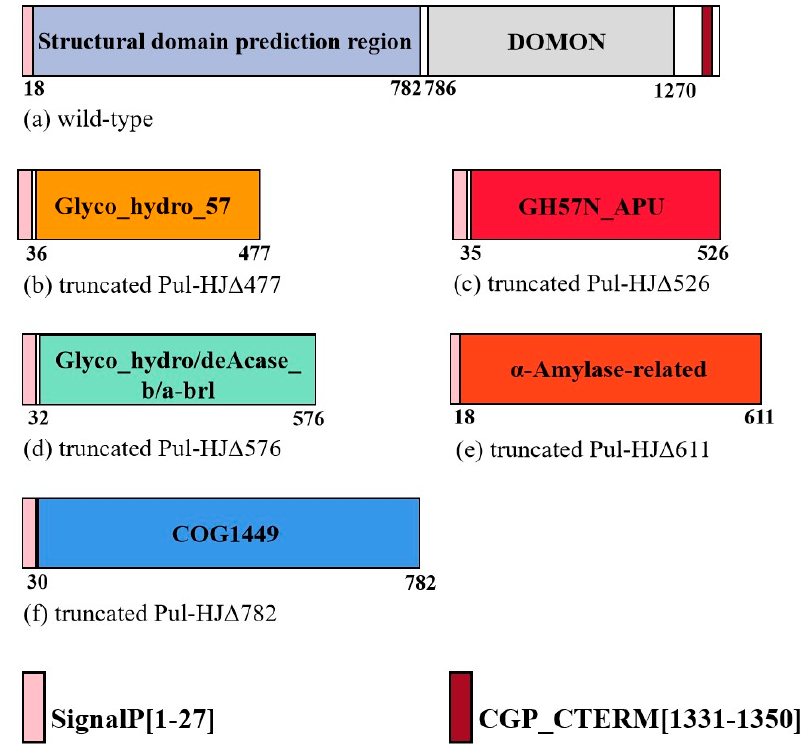
Figure 2. Sequence analysis of HJ21 and different truncates.